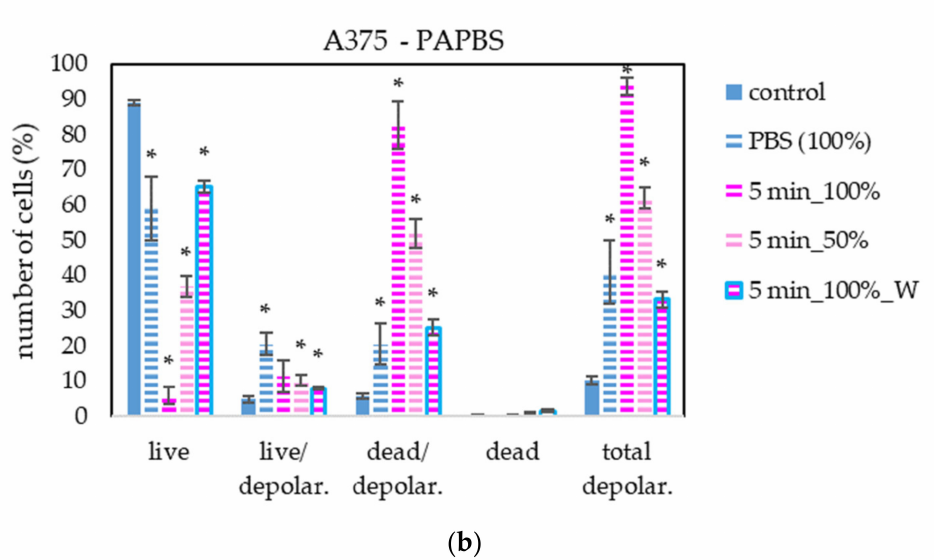
Figure 12. The effect of PAL on mitochondrial membrane depolarisation in human melanoma cells A375, measured 24 h after PAL application. Plasma-activated medium—PAM ( a ) or plasma-activated PBS—PAPBS ( b ) activated for 5 min in 100% or 50% concentration were used. Time of PAL action was 24 h (without blue frames) or 30 min, after which PAL were replaced with untreated medium (“washing”, W, blue frames). The significant results ( p < 0.05) are marked with *. Significance of 100% PAPBS was tested compared to cells in 100% PBS, significance of the other samples was tested compared to